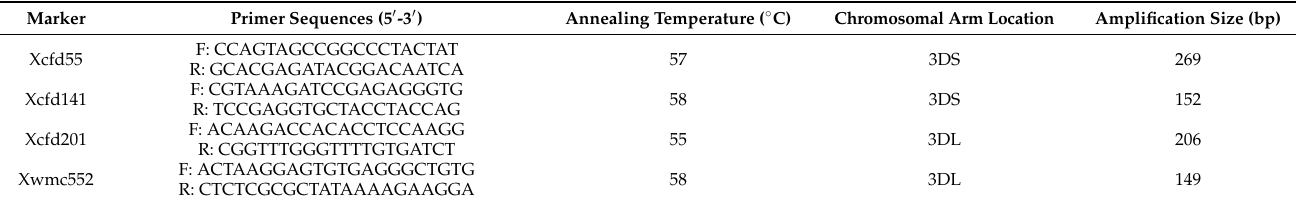
Table 1. SSR markers sequences for chromosome arm location of 3DS and 3DL in wheat were used in this study. F indicated forward primer; R indicated reverse